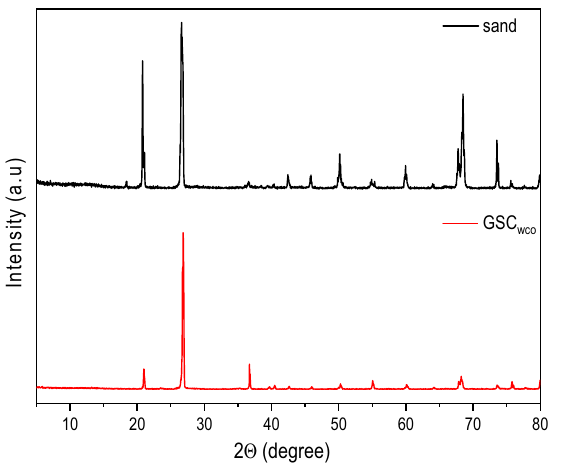
Figure 2. XRD patterns of sand and GSC WCO .